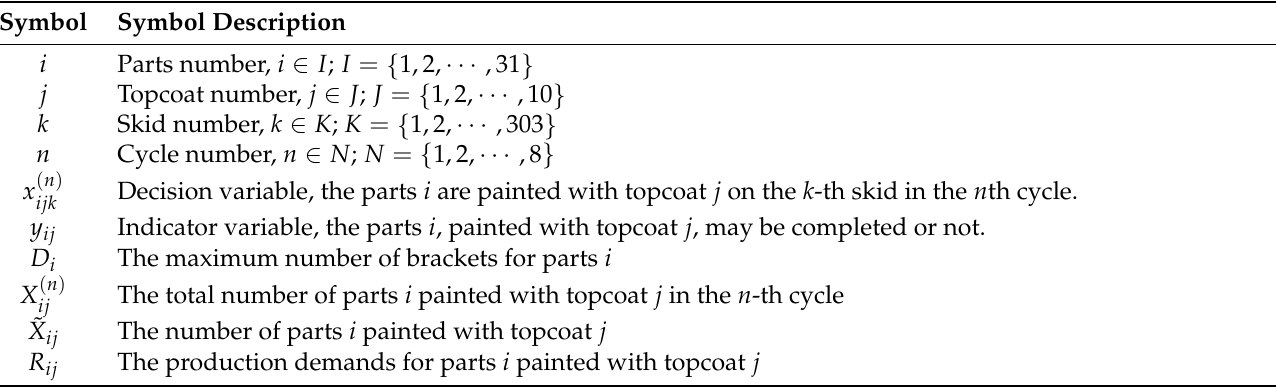
Table 2. The ten symbols used